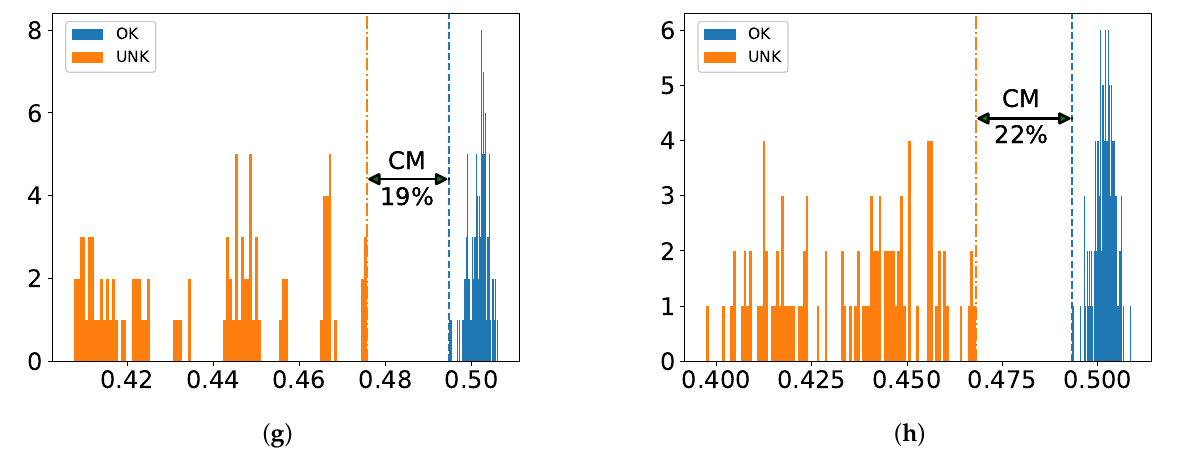
Figure 7. Histogram of one-class classifiers with the dataset Crp1k-200k. CM in Equation (1) is re- ported if available. Values on the x -axis are normalized classifier scores according to Equations (2)–(5). ( a ) HMM with PFA; ( b ) HMM with SFA; ( c ) SVM with PFA; ( d ) SVM with SFA; ( e ) IF with PFA; ( f ) IF with SFA. ( g ) AE-BN with PFA; ( h ) AE-BN with SFA.